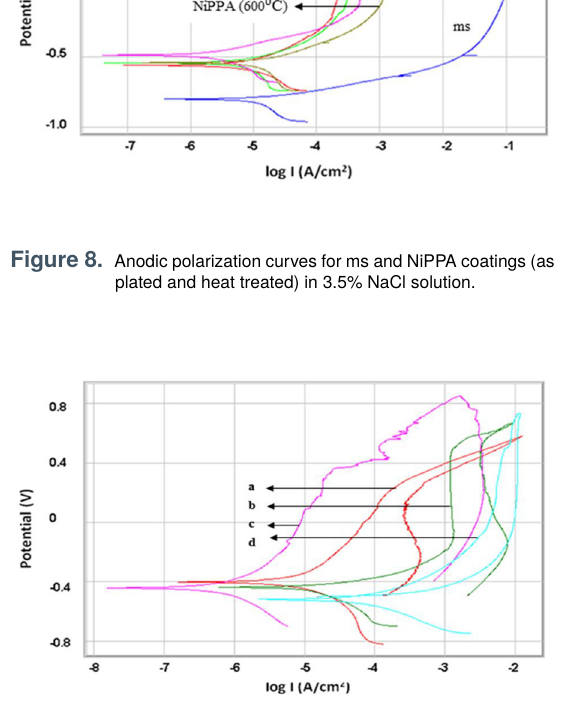
Figure 9. Cyclic polarization of NiPPA coatings (a) As plated-before exposure (b) As plated-after exposure (c) Heat treated (400 ◦ C) before exposure (d) Heat treated (400 ◦ C)-After